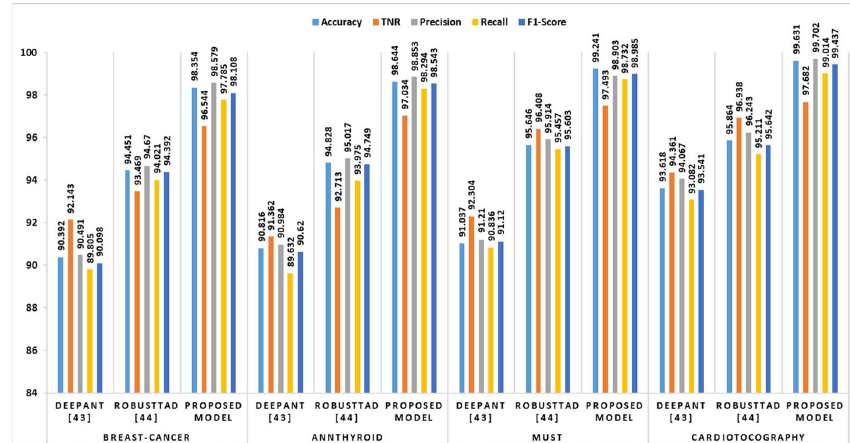
Fig. 5 Performance Metrics for different DL Methods on different Benchmark